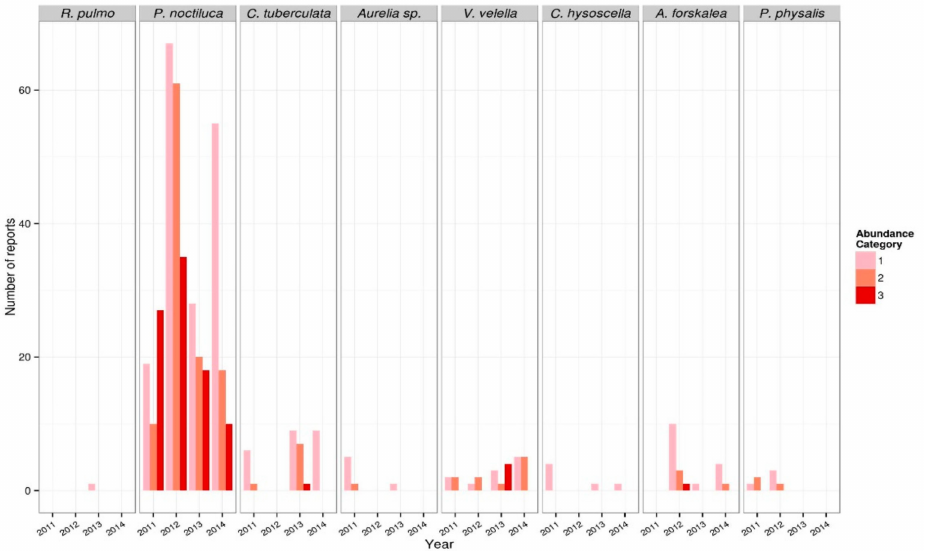
Figure 3. Total number of jellyfish reports from 2011 to 2014 for Malta. Each sector represents a different species, and the color scale represents different abundance categories (darker colors meaning higher abundance).